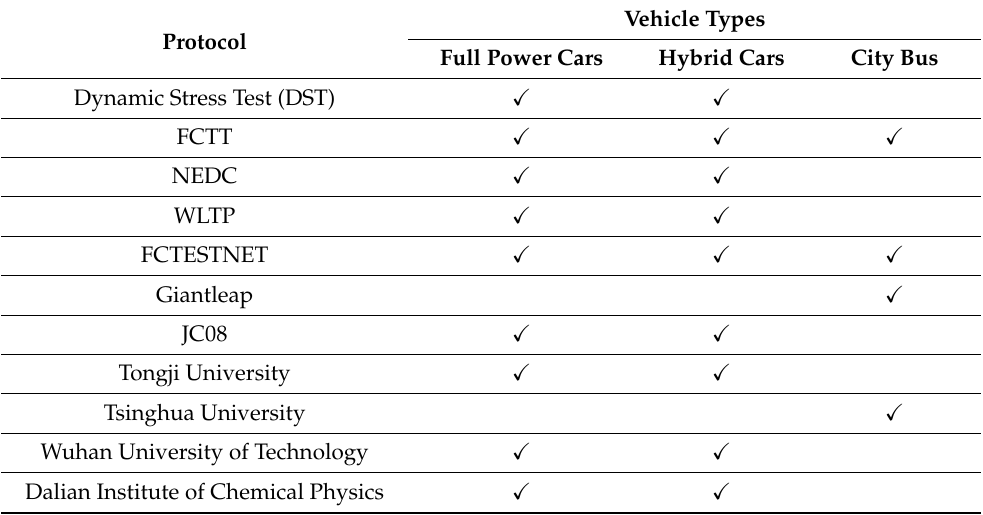
Table 7. Summary of applicable vehicle types of PEMFC durability test protocols.